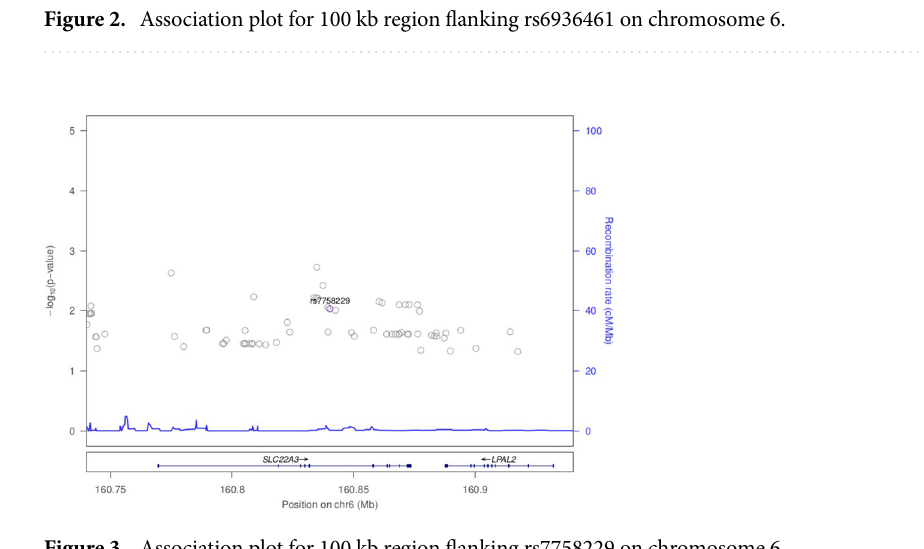
Figure 3. Association plot for 100 kb region flanking rs7758229 on chromosome